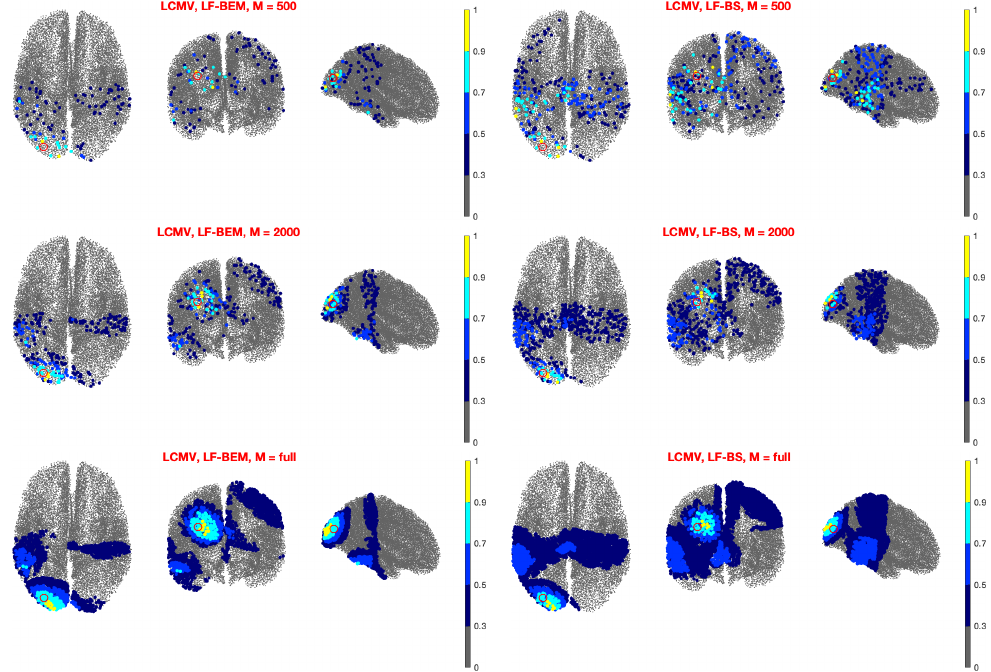
Figure 14. Right Visual evoked field: The intensity of the estimated sources, averaged over N = 10 runs, at 90 ms obtained using LCMV with M = 500 random points (first row), M = 2000 (second row) and the full source space (third row) for LF-BEM (left column) and LF-BS (right column). The red circle represents the dipole fitted using MNE.